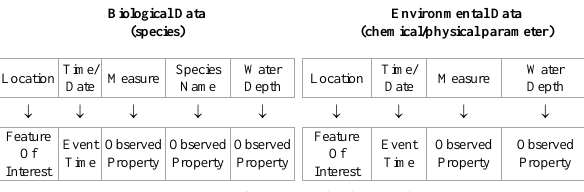
Figure 2. Comparison between limnological data structure and SOS